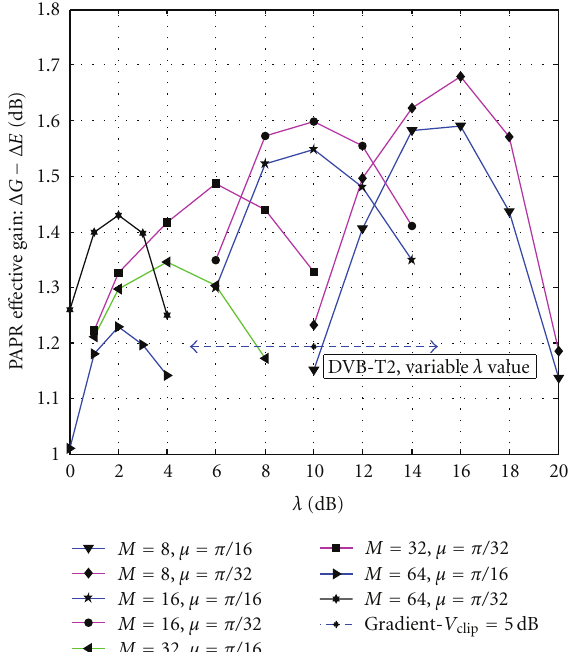
Figure 14: PAPR e ff ective gain: comparison between proposed and DVB-T2 TR techniques,